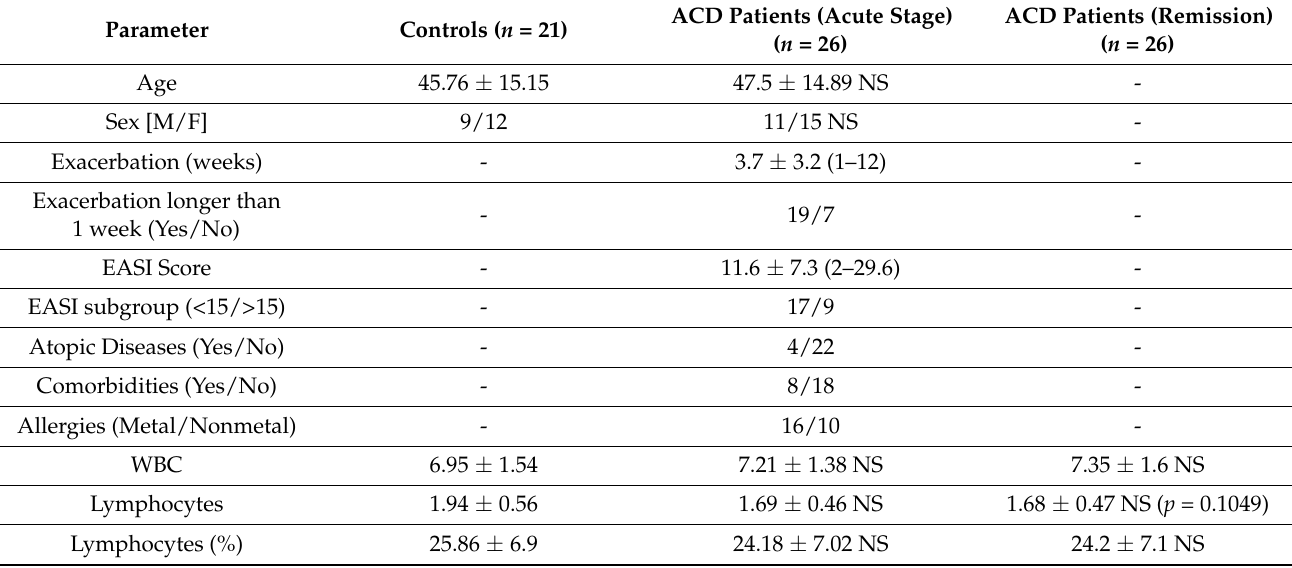
Table 1. Characteristic of the groups: Patients with ACD and